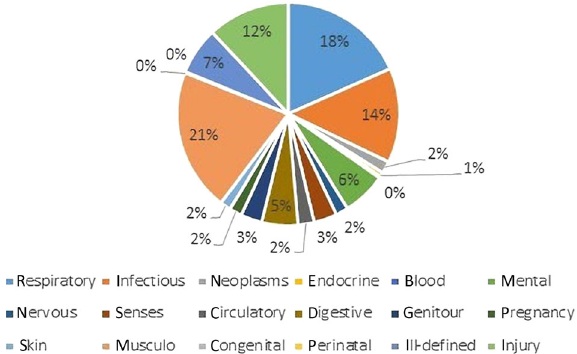
Fig. 4 Diagnoses causing work absence in the general Balearic